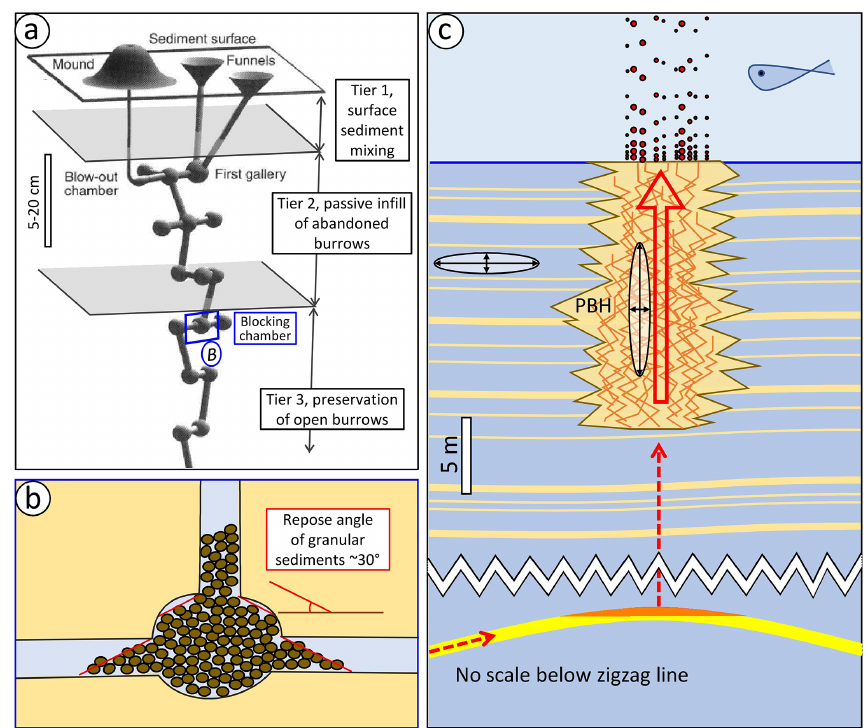
Figure 15. Fluid flow in and around the pseudobioherm (PBH). (a) Typical architecture of a recent decapod crustacean burrow ( Callianassa truncata , modified after Ziebis et al., 1996); gray surfaces indicate the hypothetical limits between bioturbation tiers 1 and 3 in Aurel (tier 4 below shown interval). The blue frame marks the shallowest chamber acting as trap for sediment shed from above and minimizing further downward sediment transfer. (b) Close-up of trapping chamber; once lateral spill-out from the chamber reaches angle of repose (ca. 30 ◦ , Allen, 1992), additional sediment from above piles up in the shaft and deeper parts of the burrow remain open. (c) Sketch of fluid circulation in and around the Aurel pseudobioherm (PBH) during its formation. The lower part represents the hypothetical deep structure focusing late thermogenic methane into the pseudobioherm; red dashed arrows at depth indicate hypothetical gas migration pathways from a source rock into the structure and further up to the base of the pseudobioherm. The upper part shows the circulation pattern of gas and compaction fluids within the pseudobioherm; orange zigzag lines represent crustacean burrows providing a connected tube network down to the bottom of the pseudobioherm. White ellipses represent permeability tensors in the pseudobioherm and host sediment, with the principal axes of minimum and maximum permeability shown by black arrows; red arrow within the pseudobioherm marks the vertical flow pattern of the gas (-charged fluids), likely with episodic escape of gas at the seafloor (red bubbles in the water